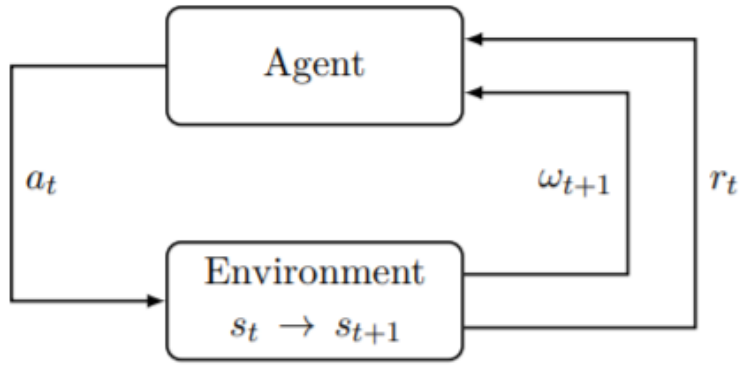
Figure 7. Agent and